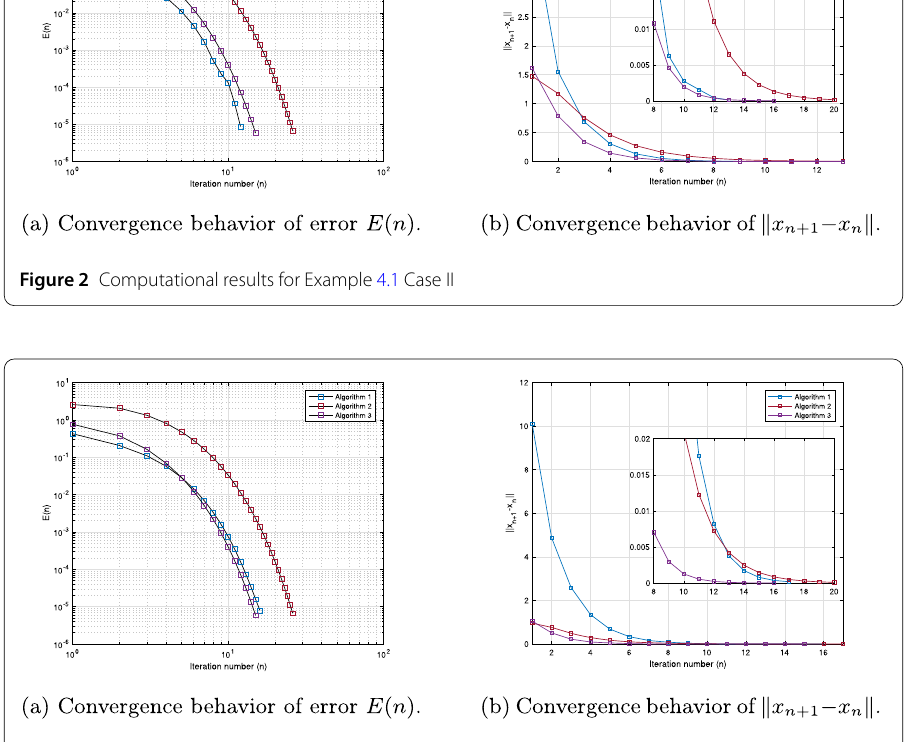
Figure 3 Computational results for Example 4.1 Case III